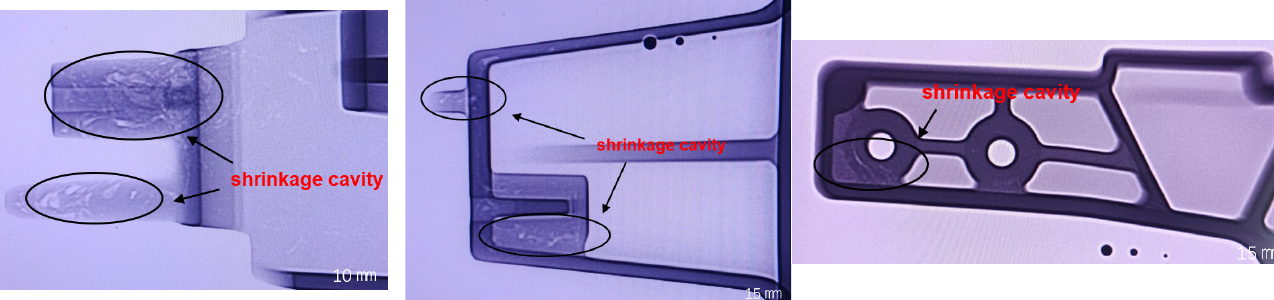
Figure 11. X-ray test before optimization.